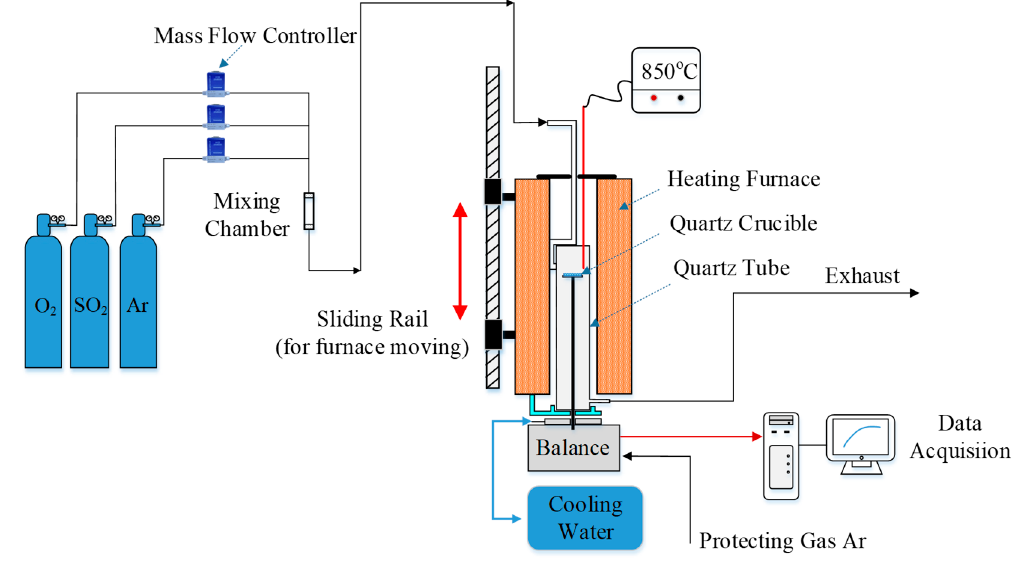
Figure 1. The schematic of the large-capacity thermogravimetric analyzer (LC-TGA) system. Two types of limestone samples from China and Korea were sieved by an ultrasonic sieving machine (Sanyuantang Mechanical Corporation, Xinxiang County, Henan Province, China) into seven groups with narrow cuts, including 0–20 µ m, 20–38 µ m, 38–75 µ m, 75–106 µ m, 106–200 µ m, 200–400 µ m and 400–600 µ m. The particle size distributions measured by Malvern are shown in Figure 2. The main cut sizes of the seven groups are listed in Table 2. The X-Ray Fluorescence (XRF) analysis for each size cut of limestone was performed, and the relative deviation of CaO content was smaller than 2%. Thus, the component was assumed the same for each type of limestone, and the average values are listed in Table 3.